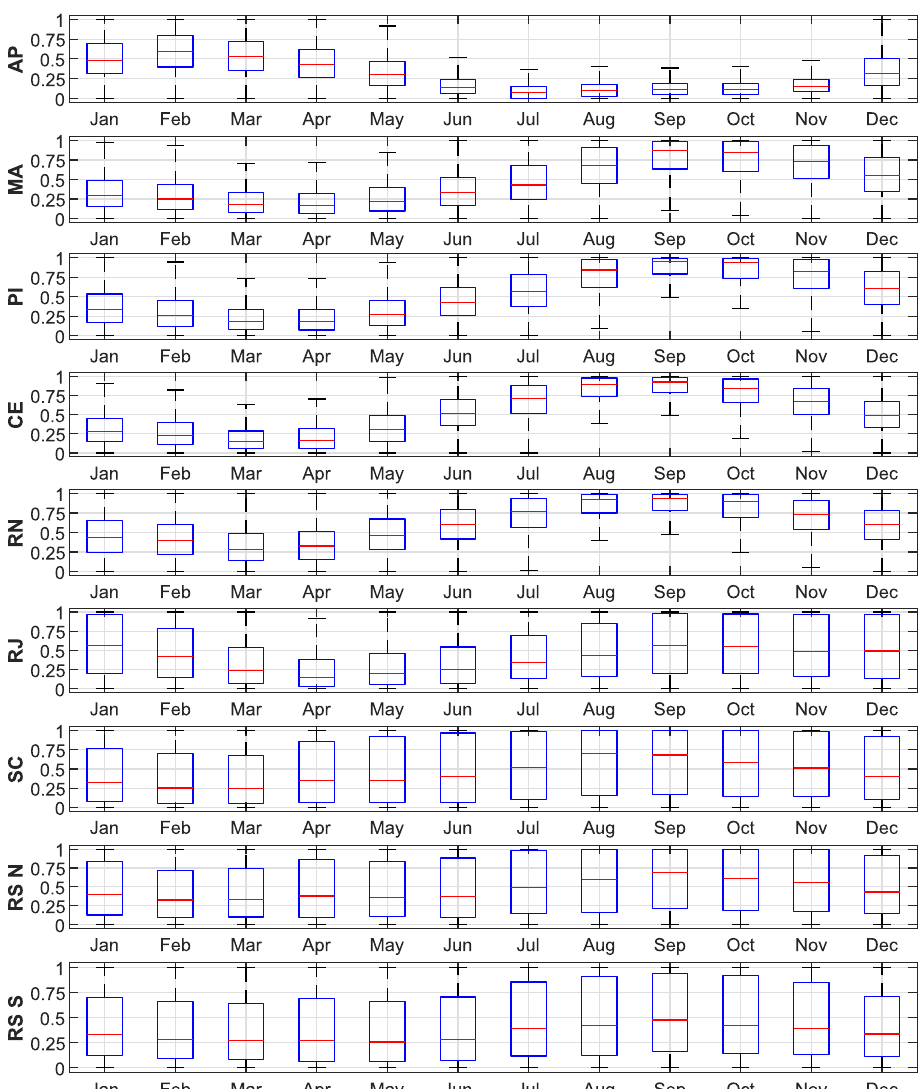
Figure 4. Capacity factor monthly distributions for individual wind farm clusters at AP (cid:63) , MA (cid:63) , PI, CE, RN, RJ, SC (cid:63) , RN-N, and RS-S. The central mark in each box is the median. Box edges are the 25th and 75th percentiles. The whiskers extend to the most extreme data points (approximately ± 2.7 σ ) and 99.3 % coverage if data are normally distributed). All stations represent wind farms under environmental licensing at IBAMA except for those identified with a star ( (cid:63)